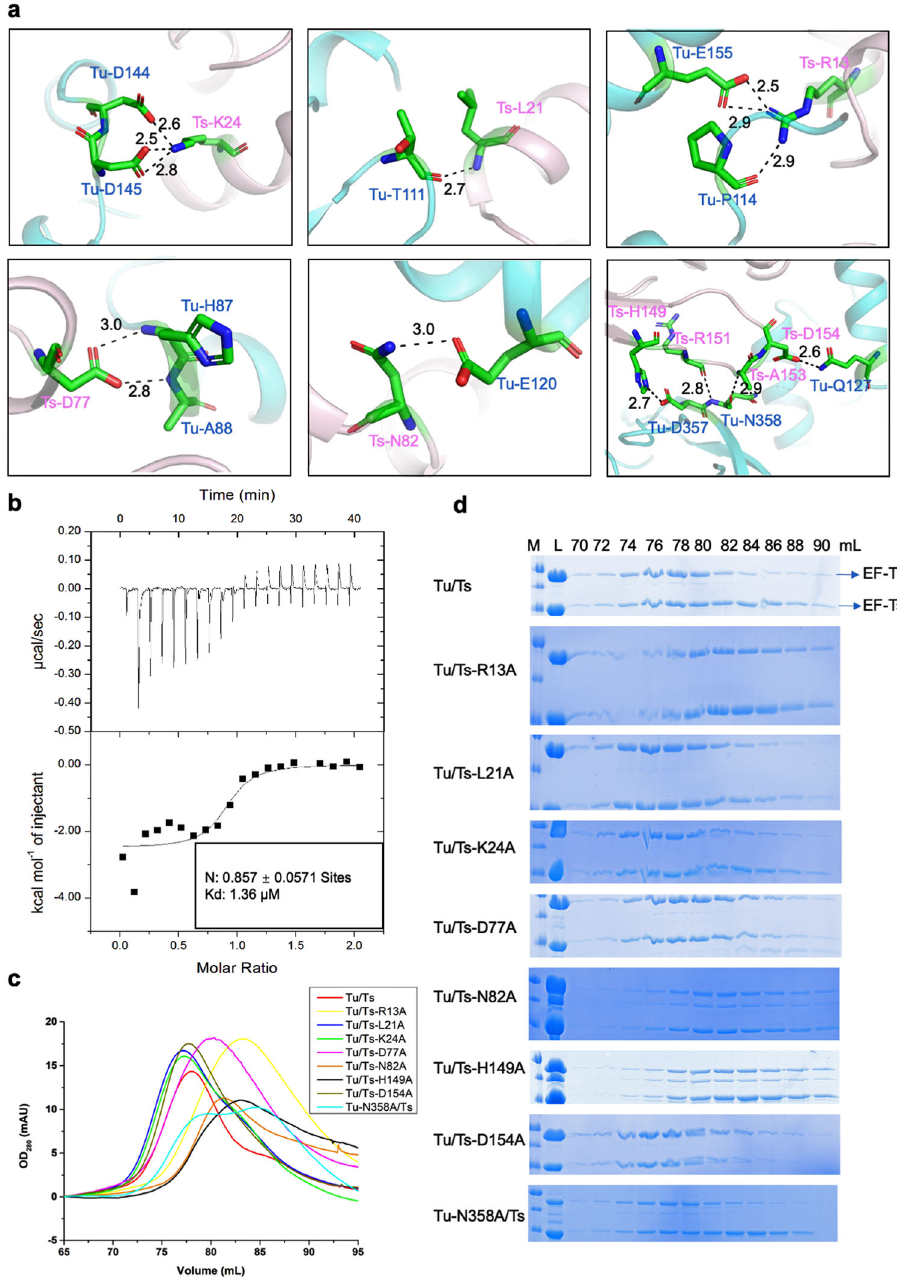
Fig. 2 Mtb EF-Tu exhibits a high binding af fi nity with EF-Ts. a Ribbon representations of crucial residues in the interface between EF-Tu (cyan) and EF-Ts (light pink). The residues were labeled and shown as sticks. The hydrogen bonds among interacted residues are shown in black dashed lines. b The isothermal titration calorimetry (ITC) result showed that the Kd value between EF-Tu and EF-Ts was 1.36 µ M. The binding molar ratio was around 1:1. c The SEC results of the EF-Tu (cid:129) EF-Ts complex and different mutants. The mutants Tu/Ts-R13, Tu/Ts-N82, and Tu/Ts-H149 dramatically changed their solution status. Tu/Ts is abbreviated for EF-Tu/EF-Ts. d The SDS-PAGE result of the EF-Tu (cid:129) EF-Ts complex and different mutants, corresponding to ( c ). M protein marker, L protein loading residue D83 was bound with the Mg 2 + ion through several water molecules as described before. G-4 contained β 5 strand and its preceding loop, and had the conserved amino acids sequence of (N/T) (K/Q) XD, which was NKAD in Mtb EF-Tu spanned from residues 138 to 145 that formed a loop to connect β 7 strand and α 5 helix. Also, residues D141 and A176 formed hydrogen bonds with the guanine ring of GDP. The G-5 region was composed of β 8 strand and α 6 helix, which spanned from residues P170 to A176, and was far from the GDP and Mg 2 + molecules (Fig. 4b).